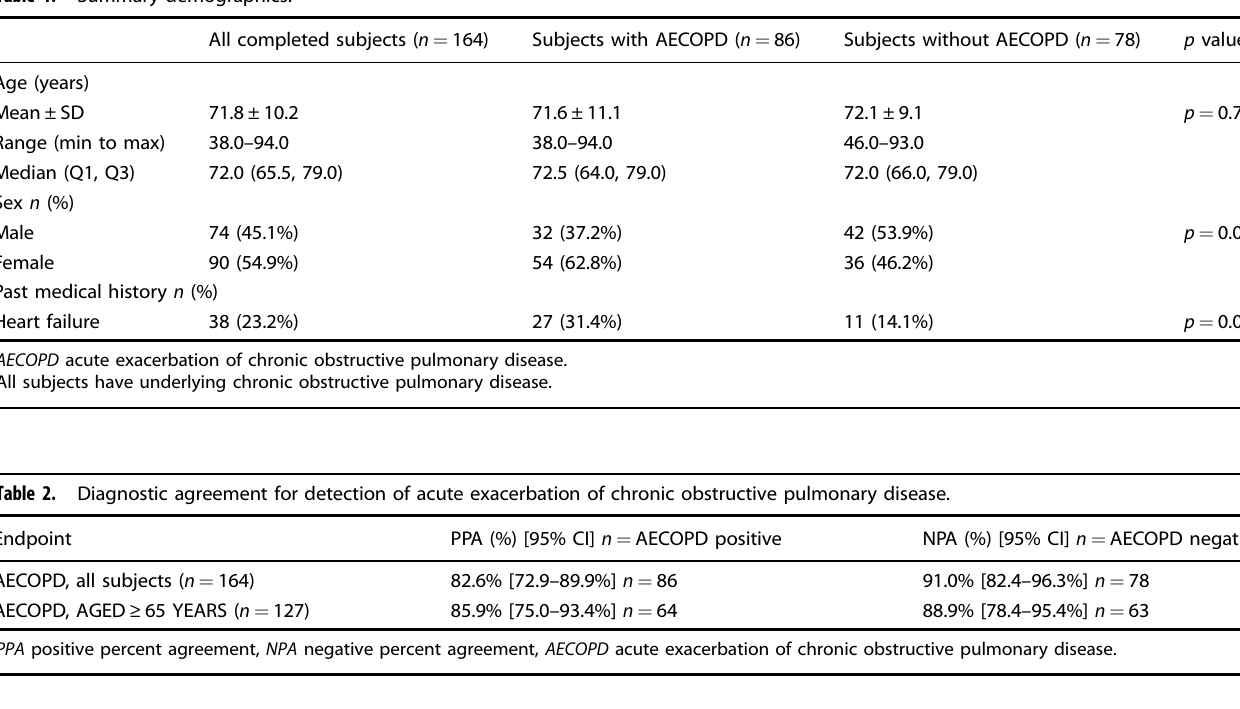
Table 1. Summary demographics.